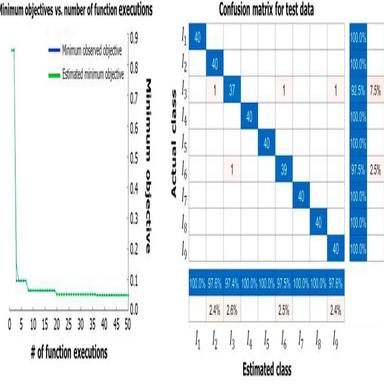
Performance evaluation results for the optimized CNN-based deep learning model for impact localization.